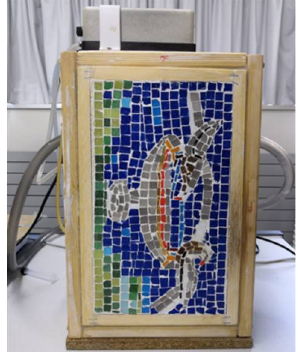
Figure 1. Front surface of the sample to be tested.